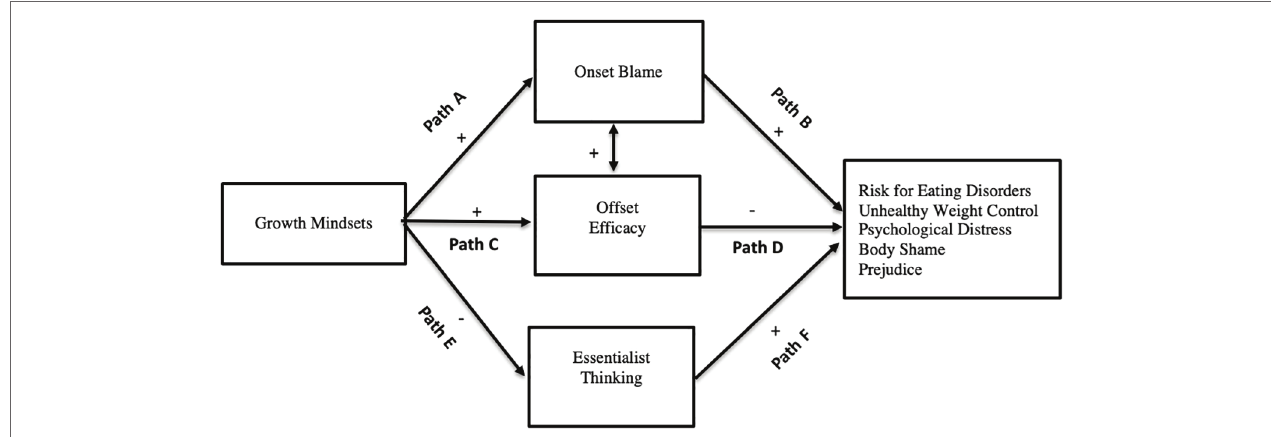
FIGURE 1 | Theoretical representation of the double-edged sword effect. Indirectly, growth mindsets of weight serve to both diminish and intensify unhealthy cognitions and behaviors related to weight as well as prejudice. Paths E and F are only tested in Study 2 and relate only to the outcome